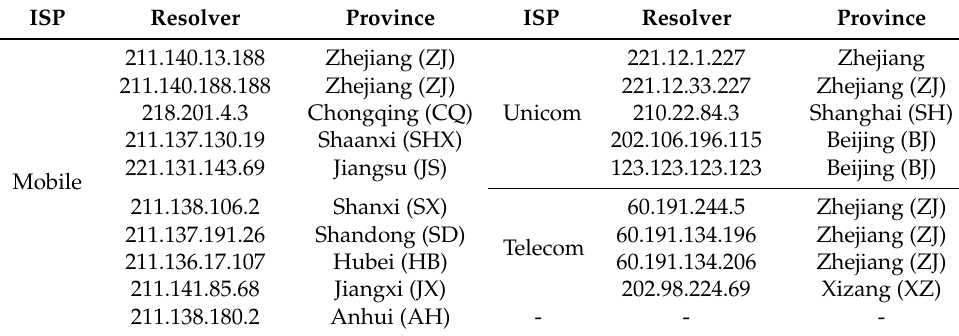
Table 3. The list of ISP DNS resolvers.